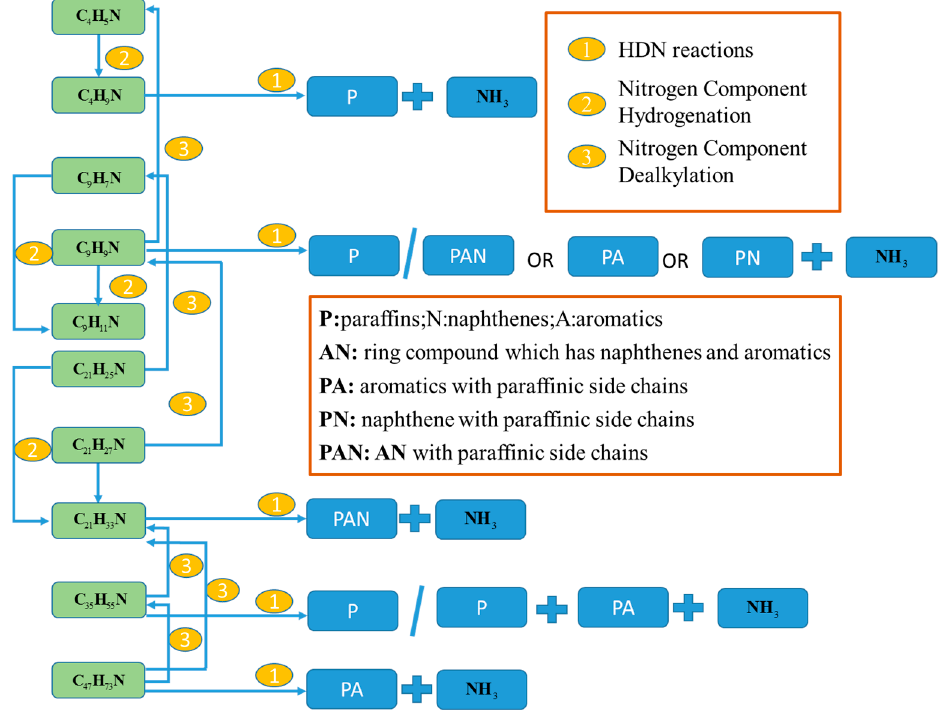
Figure 3. The reaction network of nitrogen lumps adopted in the HCR model [24]. (HDN: hydrodenitrogenation). Reproduced with permission from copyright American Chemical